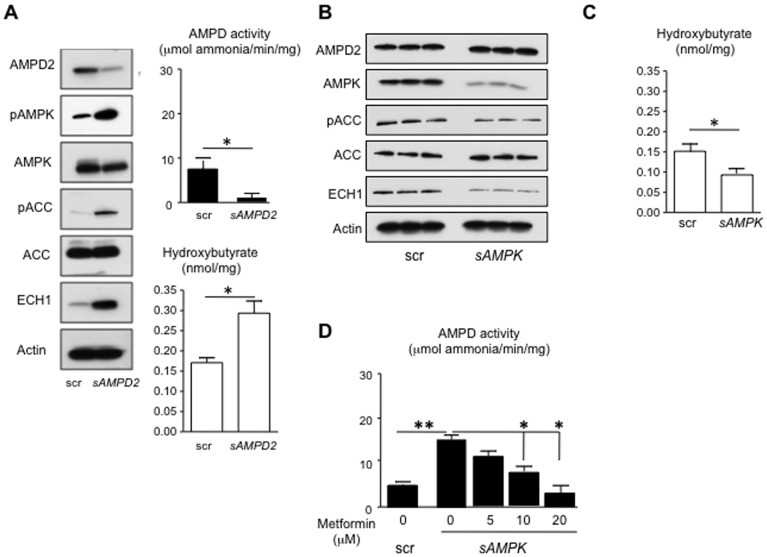
AMPK activation in AMPD2-deficient cells.A) Silencing AMPD2 expression in human hepatocytes spontaneously up-regulates the activation of AMPK. Transduction of HepG2 cells with lentiviral particles codifying for a specific silencer for AMPD2 results in significantly lower levels of AMPD activity. This is paralleled with increaseded levels Thr172 pAMPK expression as well as of their target genes ECH1 and Ser79 pACC. Up-regulation of ECH1 is accompanied with higher intracellular β-hydroxybutyrate levels. *p<0.05 B) Blockade of AMPK expression activates AMPD2. Stable silencing of AMPK is associated with significant down-regulation of ECH1 and phosphorylation of ACC at Ser79. In contrast, no change in AMPD2 expression is observed. C) Silencing AMPK expression in human hepatocytes spontaneously decreases the levels of intracellular β-hydroxybutyrate D) Metformin blocks AMPD activation in AMPK-deficient cells in a dose-dependent manner. *p<0.05, **p<0.01.